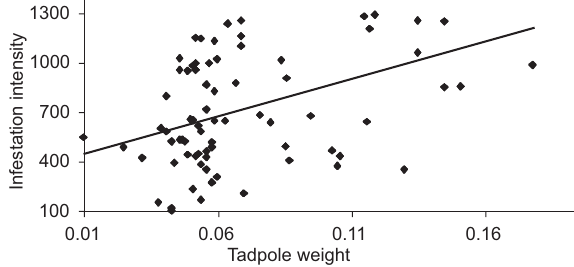
Figure 5. Linear regression analysis between infestation intensity by Trichodina heterodentata and weight of Rhinella pombali tad- poles. Heavier tadpoles show higher infestation